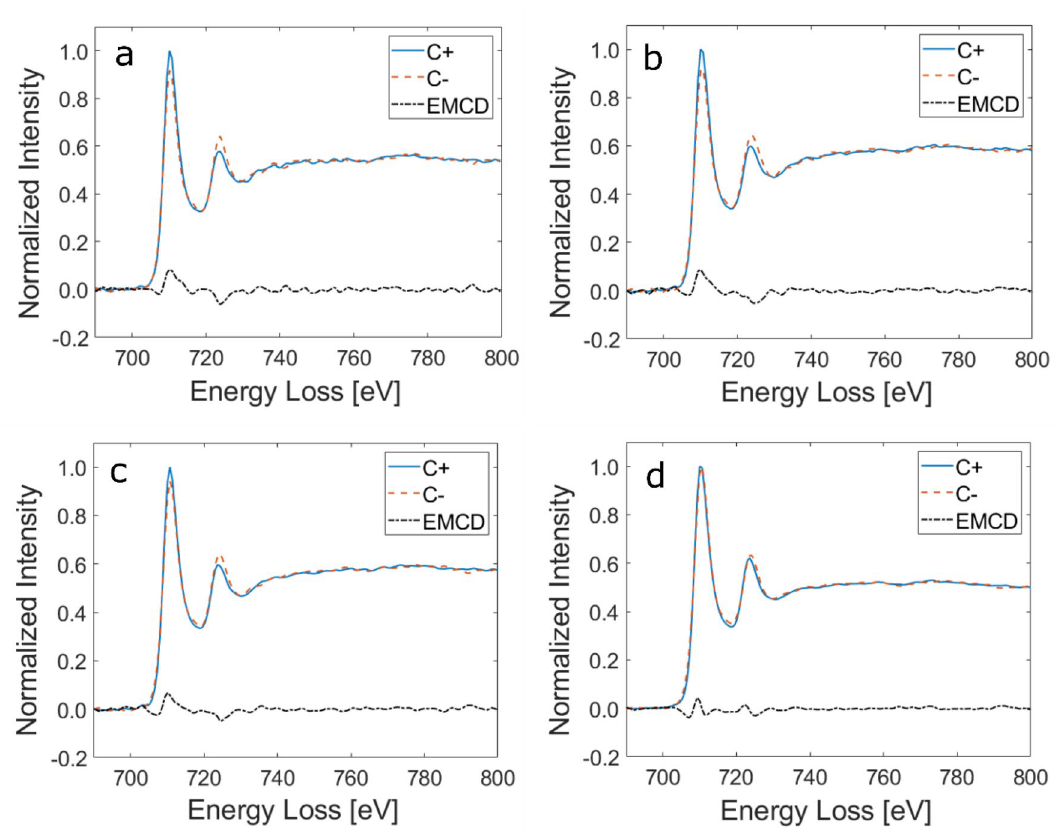
′ ′ / I 0 ) orientation intervals (a) 0.76–1.0 (b) 0.51–0.75 g